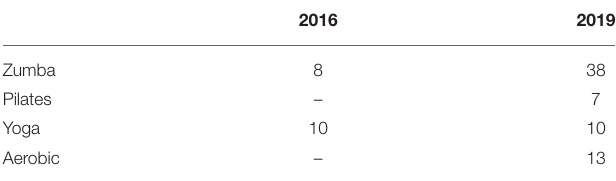
TABLE 7 | Number of participants in exercise